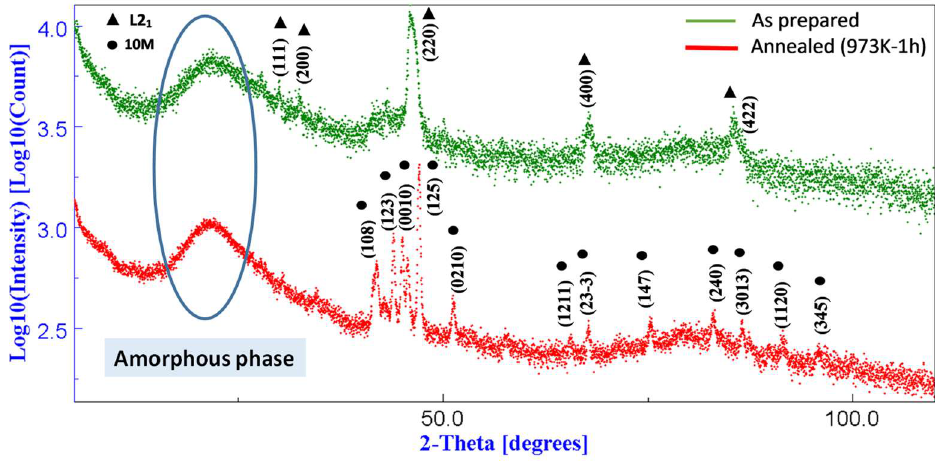
Figure 1. XRD spectra of as-prepared and annealed Ni 2 FeSi glass-coated microwires samples. For annealed sample (at 973 K for 1 h), several peaks are observed in comparison to the as-prepared one. The reflection peaks are recognized to be a monoclinic structure with modulation. Thus, XRD patterns of Ni 2 FeSi alloy annealed at 973K for 1 h and measured at room temperature demonstrates a modulated martensitic phase, which present a five- layered monoclinic 10 M structure, with cell parameter: a = 0.514 nm, b = 0.499 nm, c = 2.506 nm, and β = 92.26°. Consequently, by increasing the temperature, the cubic high temperature parent austenite phase transforms into a monoclinic martensitic structure with modulation 10 M. In other words, when applying an external stress (temperature change in our case), the martensitic domains move and permit the creation of a large